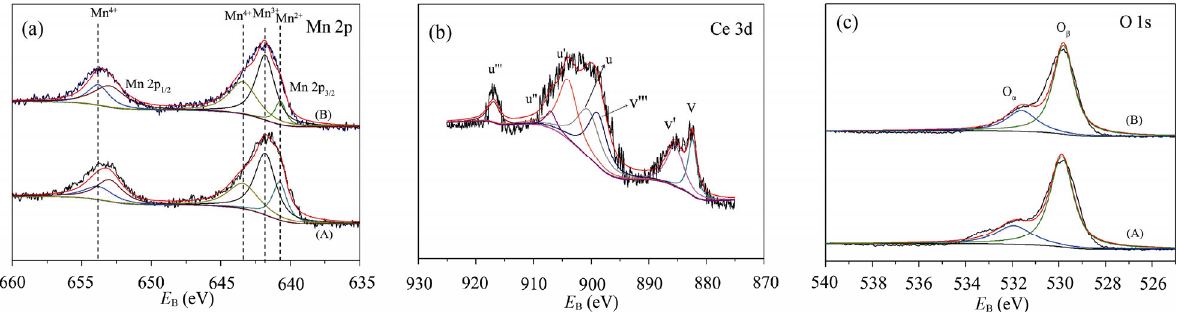
Fig. 5 XPS spectra for (a) Mn 2p, (b) Ce 3d, and (c) O 1s of the catalysts: (A) MnO x –CeO 2 /TiO 2 and (B) MnO x –CeO 2 / TiO 2 –1%NG. Table 3 Atomic surface compositions of MnO x –CeO 2 /TiO 2 and MnO x –CeO 2 /TiO 2 –1%NG(fresh, spent) obtained by XPS Atomic composition